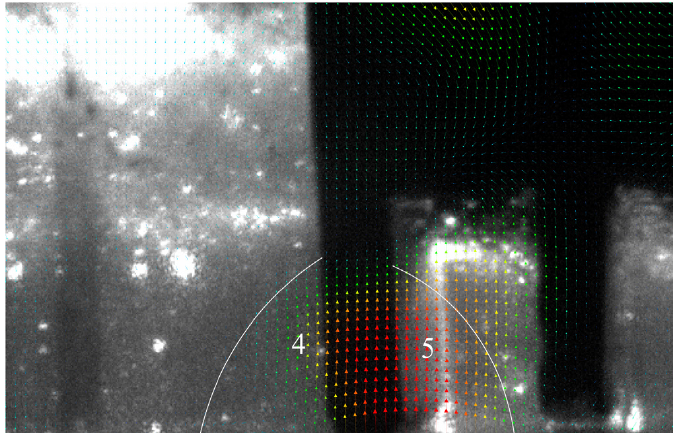
Figure 12. ( a ) X − direction contour diagram and ( b ) Y − direction contour diagram of soil displacement for MN − 15 model.